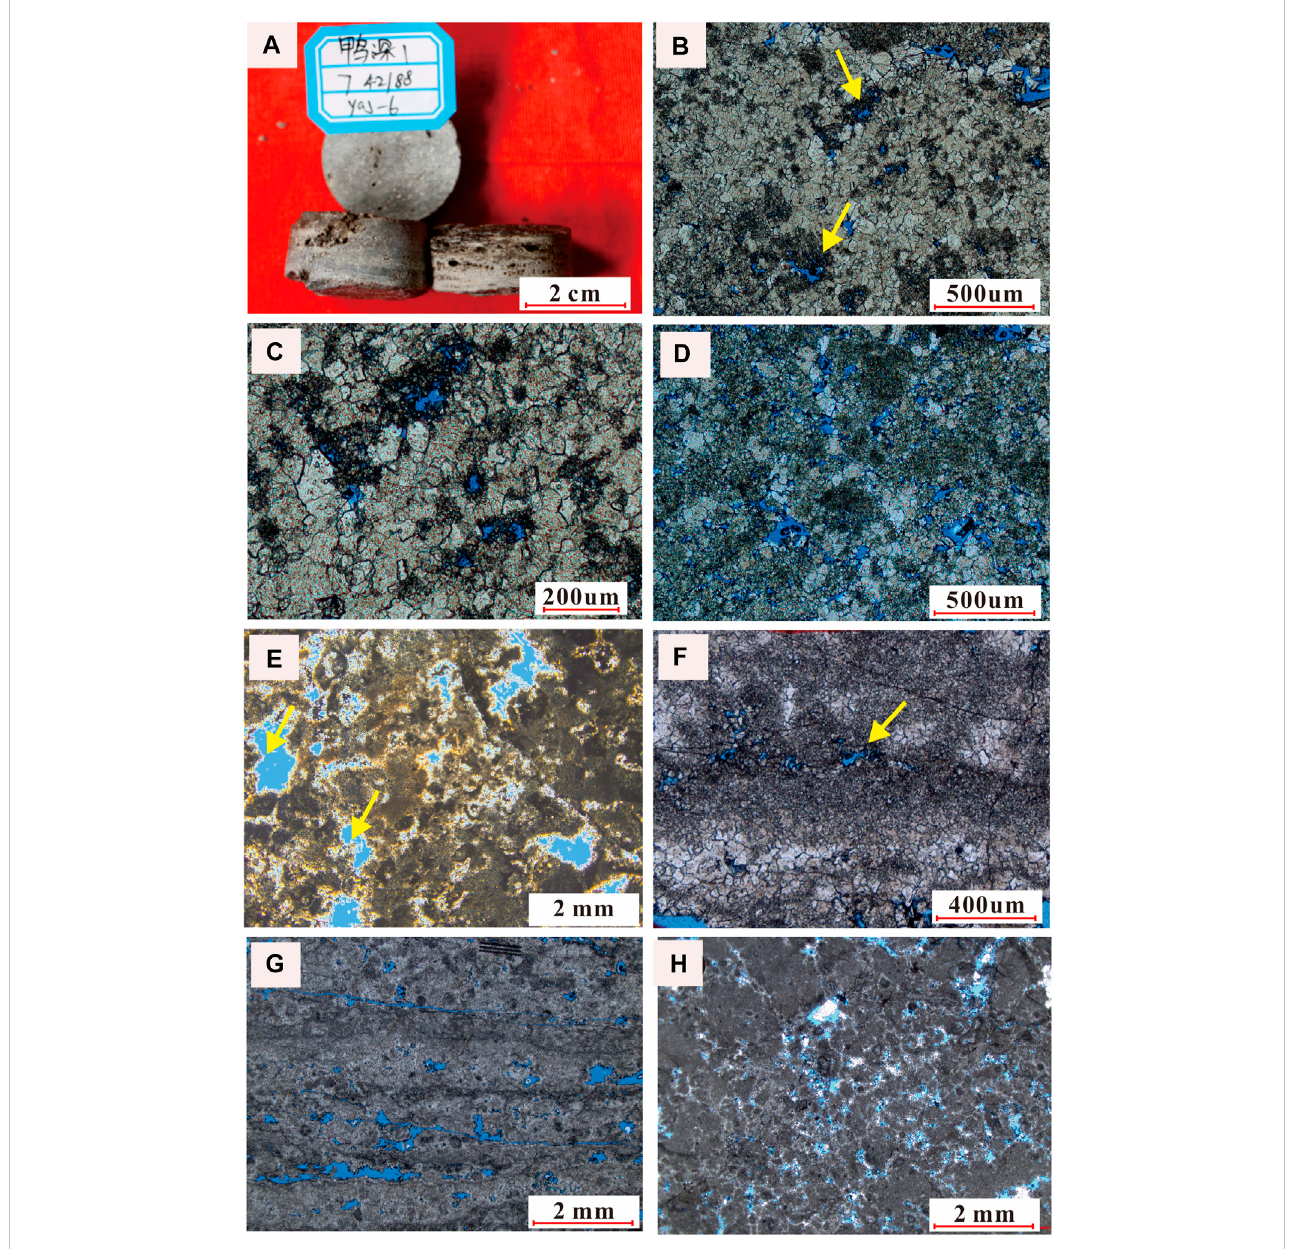
FIGURE 1 Pores charachteristics of microbialites in Member IV of the Leikoupo Formation. (A) Vuggys developed along the laminations in stramatolites; (B,C) The intra-clots dissolution pores with poor connectivity; (D,E) Inter-clots dissolution pores with a good connectivity; (F) Small intra-lamina dissolution pores; (G) Inter-lamina dissolution pores; (H) Inter-granular dissolution